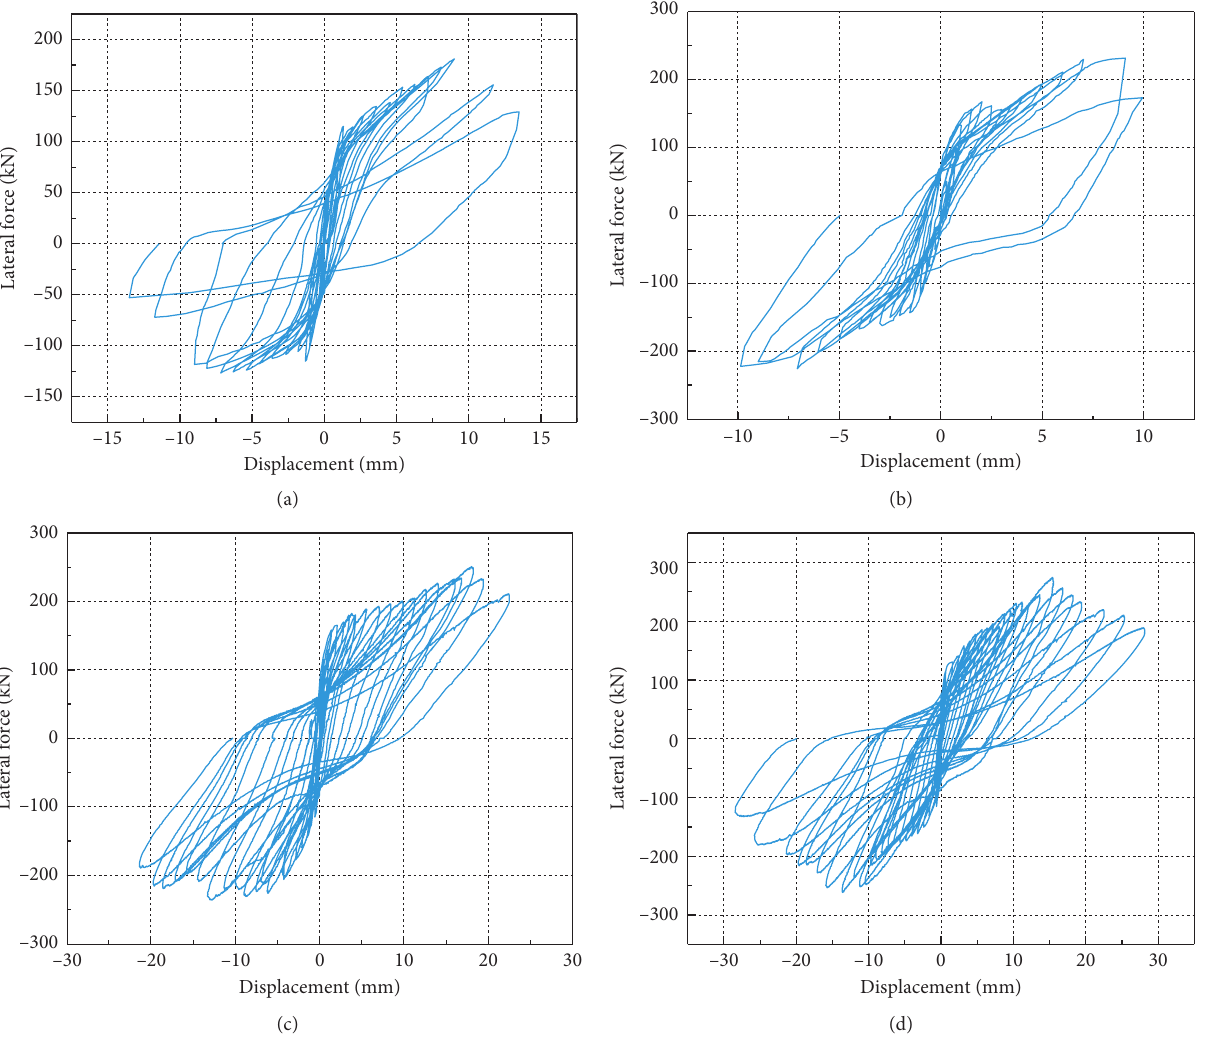
Figure 10: Hysteretic curve of specimens. (a) Specimen W-1, (b) specimen W-2, (c) specimen JW-1, and (d) specimen